Question: Express in one sentence what the figure is showing.
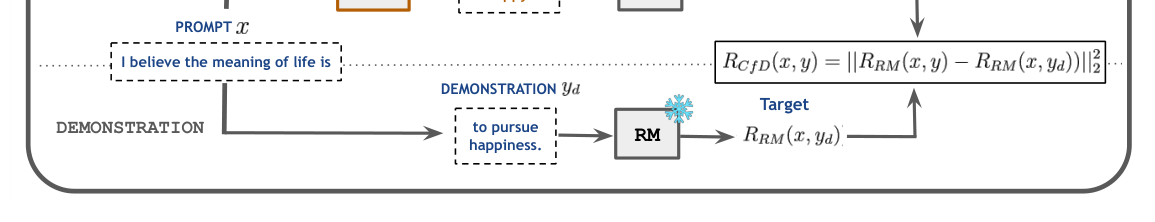
Answer: The RCfD objective is the L2-distance between the reward from the LM and the reward from the demonstration. Given a prompt x, a demonstration yd, and the LLM continuation y, the RM computes the demonstration reward RRM(x, yd), and the LM reward RRM(x, y). Instead of maximizing R(x, y) as in standard RL, we here aim at maximizing the RCfD objective defined as RRCfD(x, y) = −||RRM(x, y) −RRM(x, yd)||2 2.